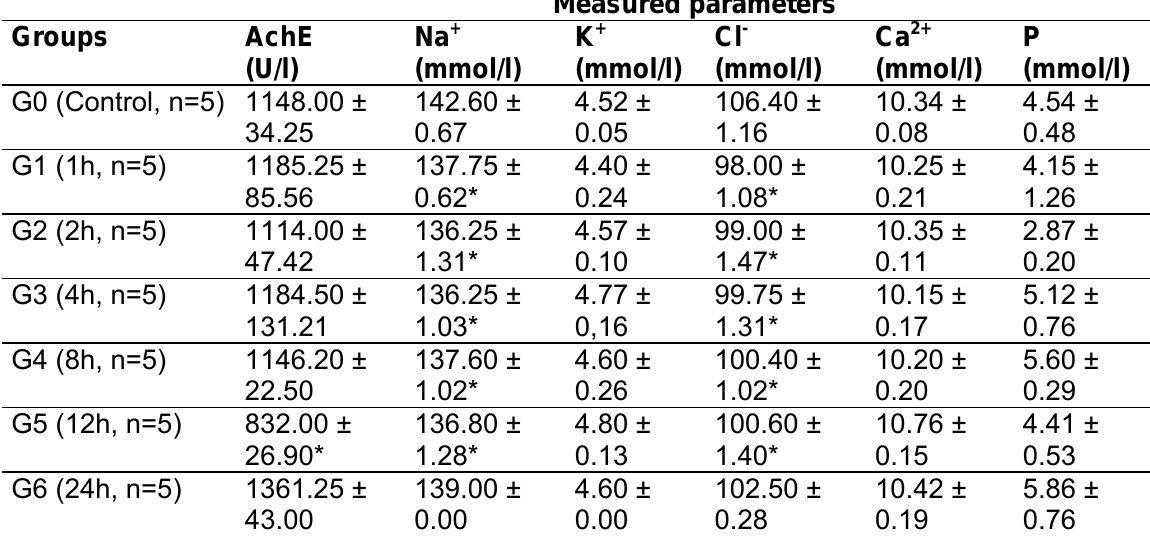
Table 1: Effects of Androctonus crassicauda venom on acetylcholinesterase (AchE) activity and on serum Na + , K + , Cl - , Ca 2+ and P levels in rats on the 1 st, 2 nd , 4 th , 8 th , 12 th , and 24 th hours after administration.